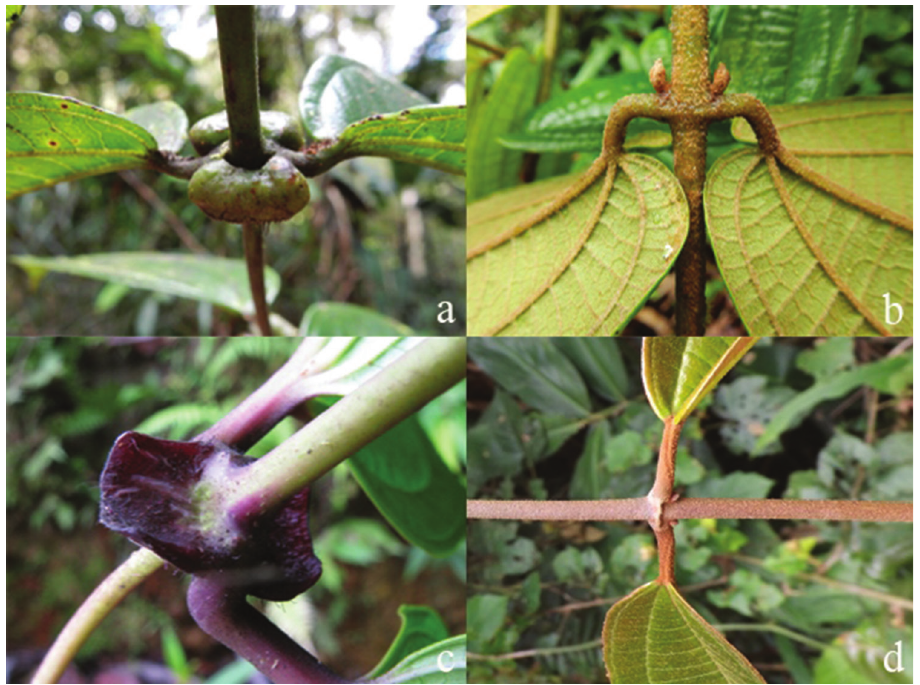
Figure 2. Nodes of Dissochaeta a D. glabra b D. macrosepala c D. pulchra d D. viminalis . Photographs by D. Penneys ( a , b ), J. Henrot ( c ), A. Kartonegoro ( d